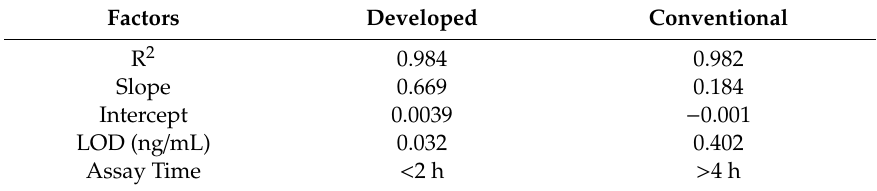
Figure 6. Plot represented ( a ) the performance of classical ELISA. Error bar indicates the standard deviation of three repeated experiments (black dots) and ( b ) along with the fitted curve. Table 1. Representing the comparative analysis of developed and conventional ELISA method.